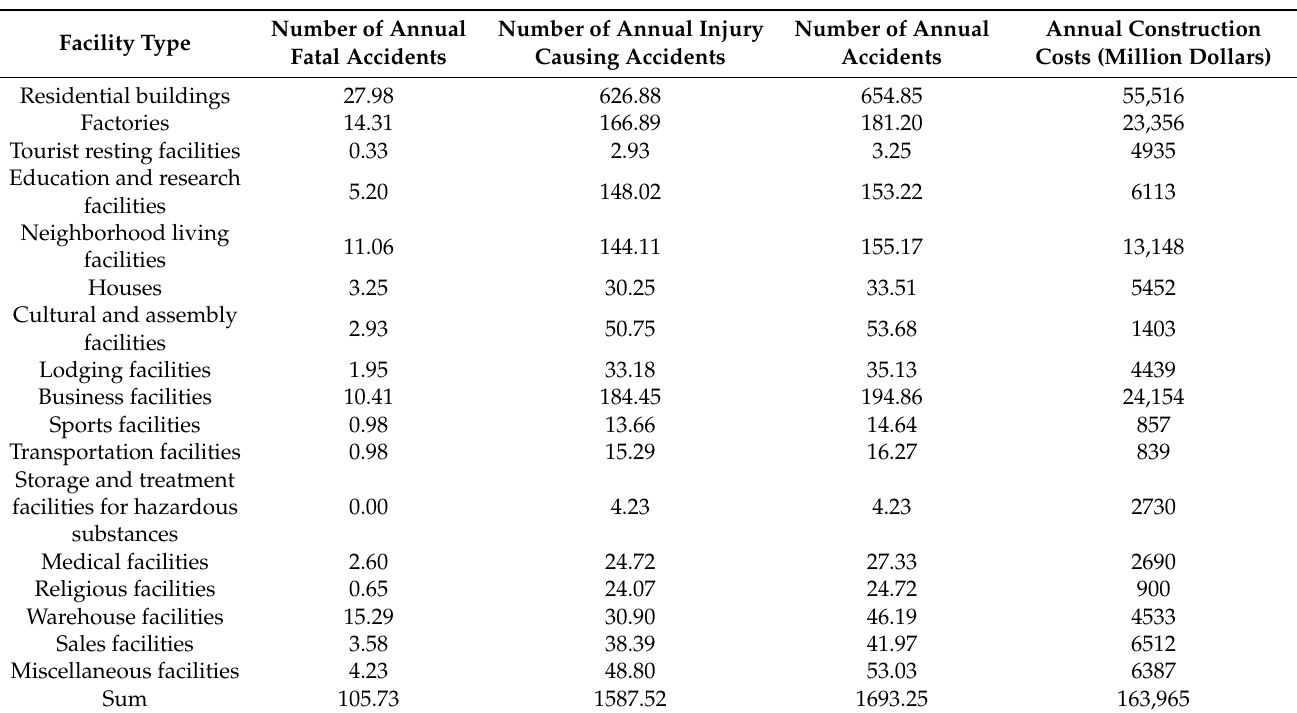
Table 2. Classification of collected